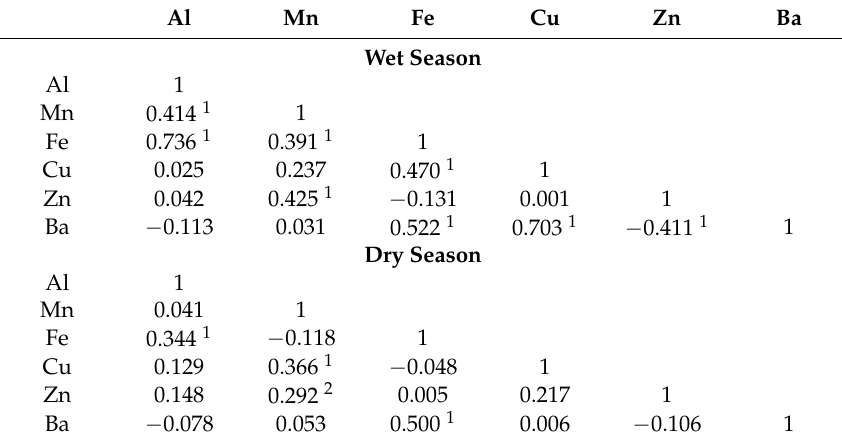
Table 4. Pearson correlation matrix of dissolved heavy metals in the Mun River.